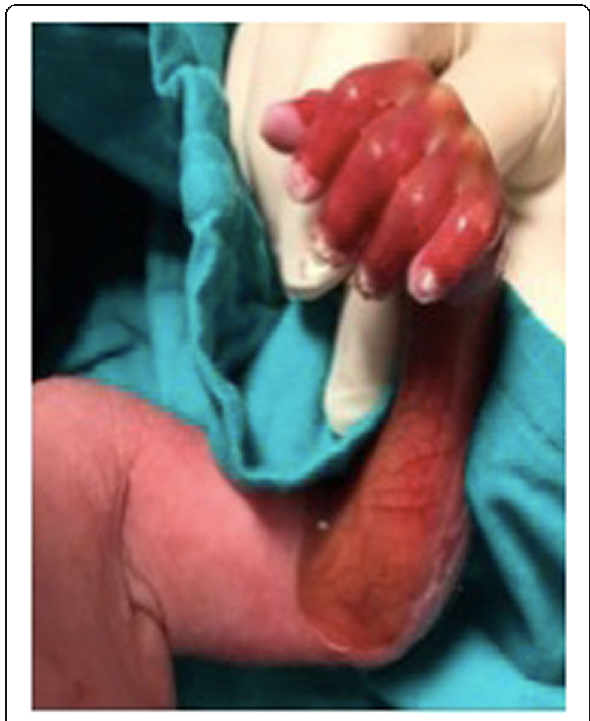
Fig. 2 Dystrophic nails of the patient